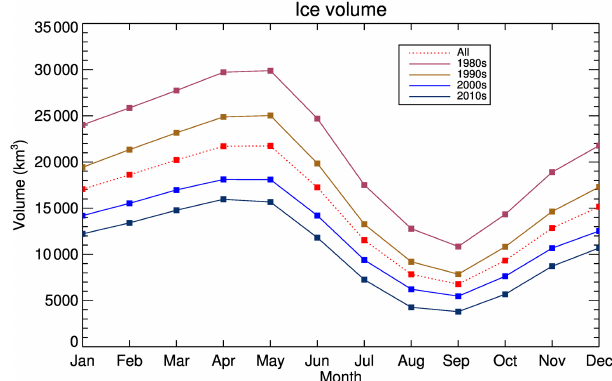
Figure 17. IceAgeDerived mean annual cycle of ice volume in 1980s, 1990s, 2000s, 2010s, and in all years over the Arctic Ocean.